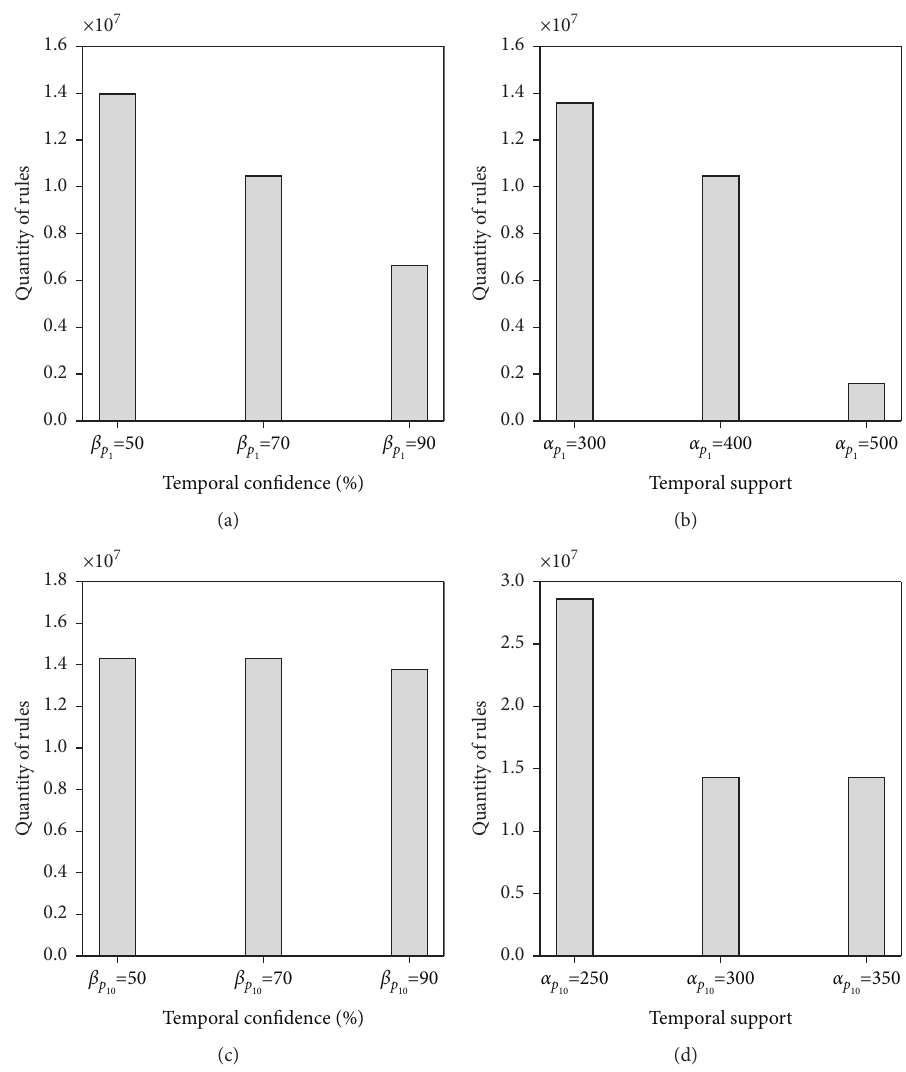
Figure 5: The quantity comparison of TARs based on the mushroom data set. (a) Q � p � 300. (d) Q � p 􏼈 􏼉 and α (c) Q � p p 10 10 Table 8: Execution time (ms) of four methods on the mushroom data set when Q � p